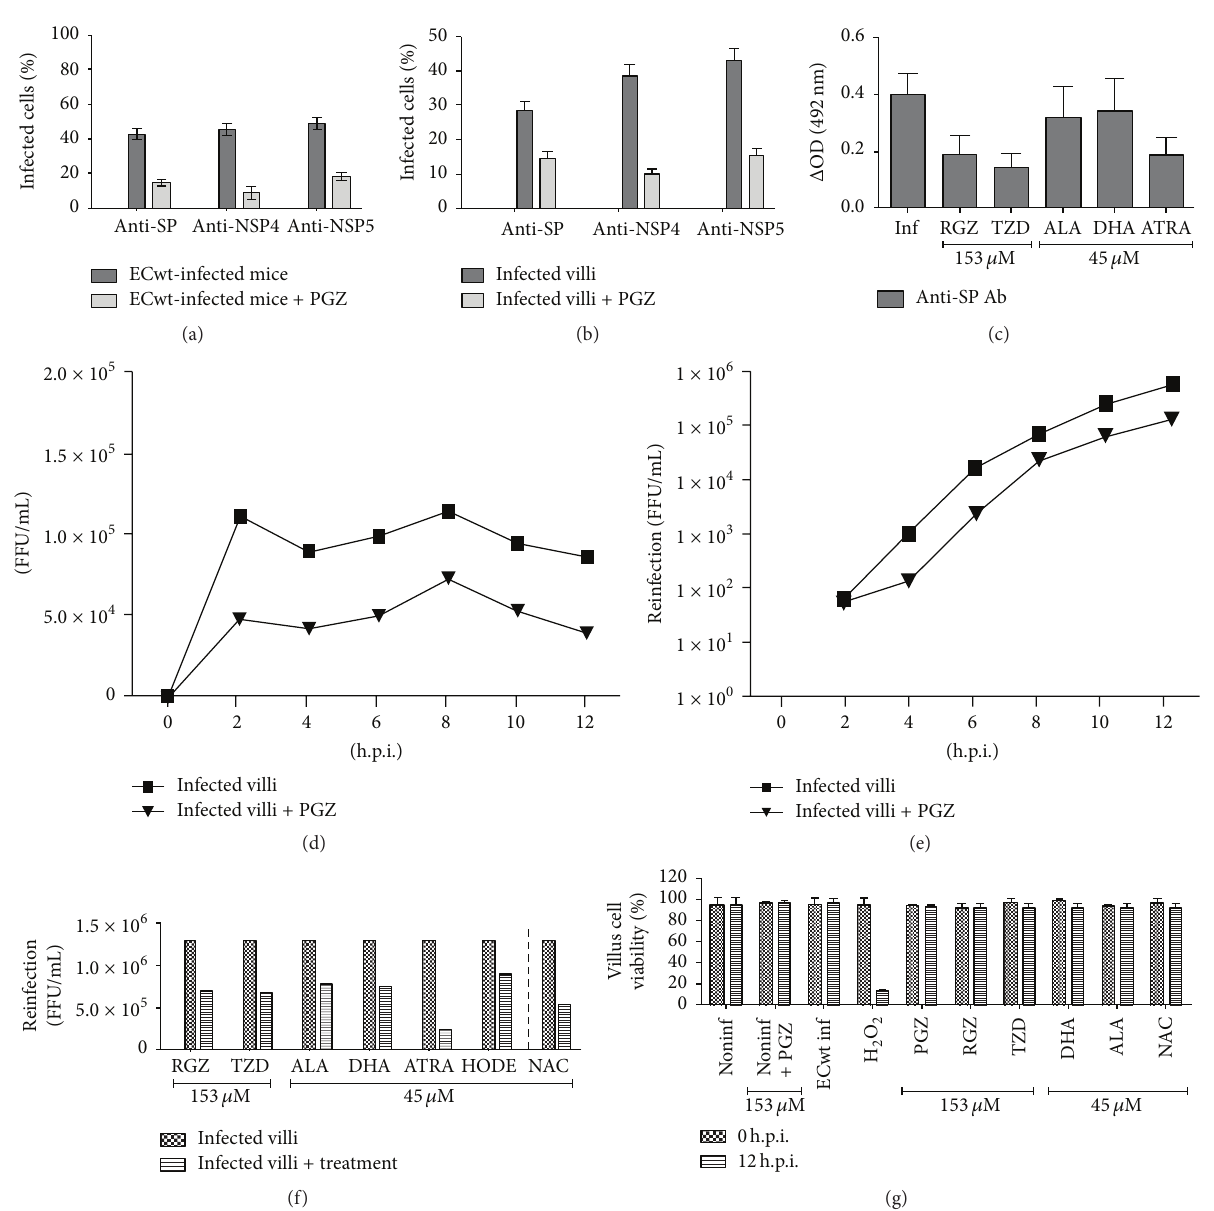
Figure 1: Effect of PPAR 𝛾 agonists and ATRA on ECwt infectivity in small intestinal villi. (a) Immunocytochemistry analysis using antibodies against viral structural proteins (SP) and nonstructural proteins (NSP4 and NSP5) present in villi from in vivo ECwt-infected mice ( 𝑛 = 3 per experiment) that had been treated or not with PGZ. (b) Immunocytochemistry analysis as in (a), except that villi isolated from mice ( 𝑛 = 3 per experiment) were infected in vitro with ECwt and treated or not with PGZ. (c) Capture ELISA analysis of lysates from in vitro ECwt-infected villi that had been treated or not with PGZ, RGZ, TZD, ALA, DHA, or ATRA. Viral antigen was detected with anti-SP antibodies (Ab). (d) Infectious titers of lysates from in vitro ECwt-infected villi that had been treated with PGZ. Viral titers were determined by immunochemistry assay using anti-SP antibodies. (e) Infectious titers of lysates from in vitro ECwt-infected villi that had previously been inoculated with the villus lysates analyzed in (d) and treated again with PGZ. (f) Infectious titers of lysates from in vitro ECwt-infected villi that had previously been inoculated with lysates from villi treated with RGZ, TZD, ALA, DHA, or ATRA and then treated with these same PPAR 𝛾 agonists. (g) Cell viability of villus cells determined with the trypan blue exclusion test. H 2 O 2 was used as a control. Data are presented as mean ± SD from three independent experiments performed in